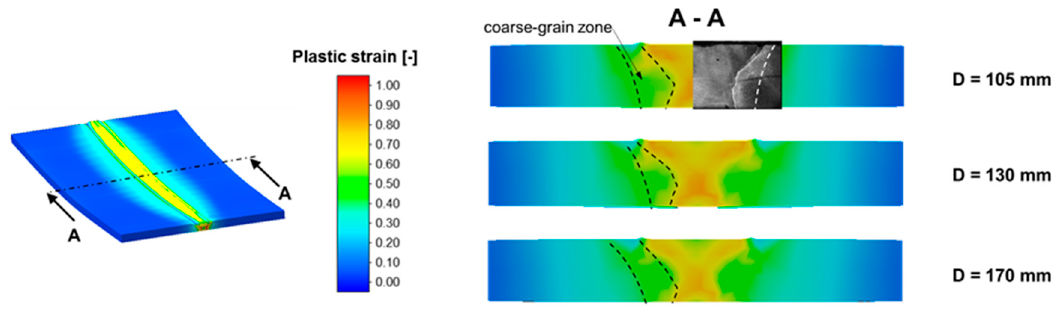
Figure 21. Plastic strain distribution after rolling.